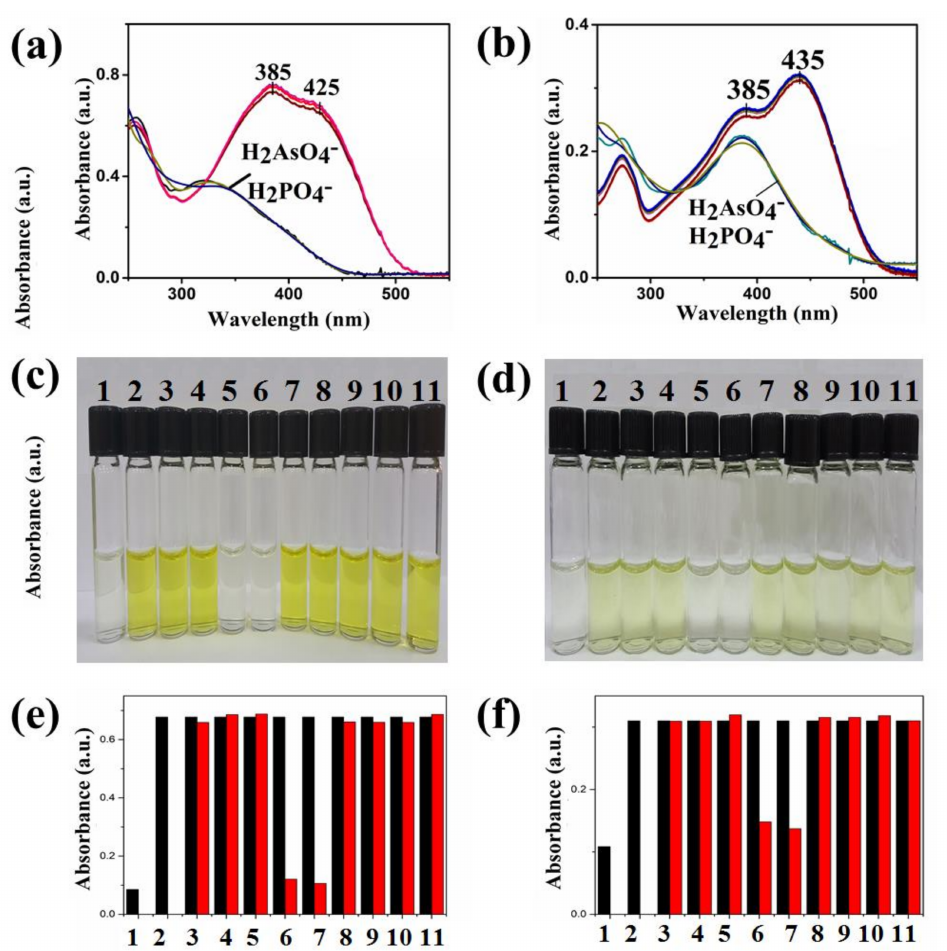
Figure 4. ( a ) and ( b ) UV-vis spectra interference of 1 and 2 in the presence of cyanide with different anions respectively: interfering anions ( – CN − , – N 3 − , – I − , – H 2 PO 4 − , – H 2 AsO 4 − , – F − , – SCN − , – Cl − , – Br − , – AcO − ), ( c ) and ( d ) colorimetric change of 1 and 2 in the presence of cyanide